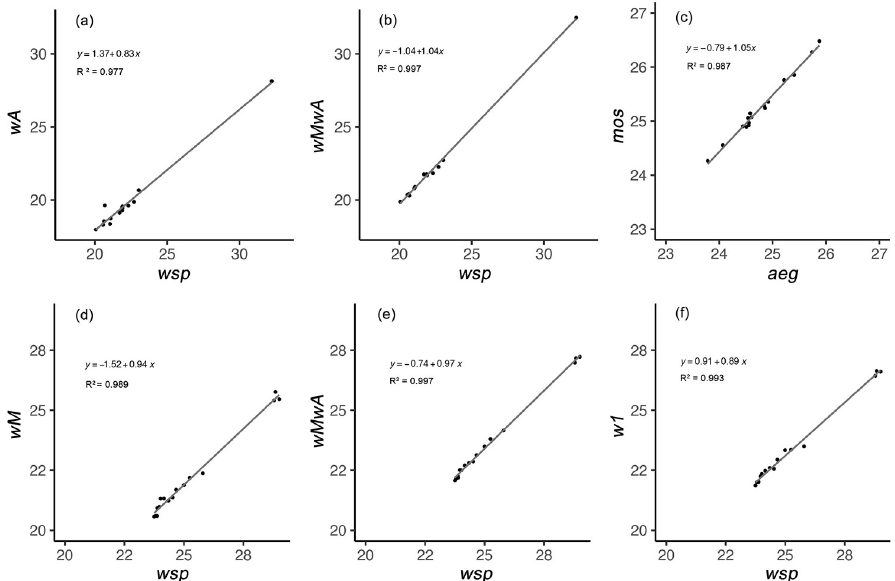
Fig 4. Variation in C q values when using different Wolbachia primers for the same samples. Correlation of C q values between (a) wA and wsp primers in Wolbachia w AlbBscreening; (b) wMwA and wsp primers in Wolbachia w AlbB screening; (c) mos and aeg primers in Aedes aegypti screening; (d) wM and wsp primers in Wolbachia w Melscreening; (e) wMwA and wsp primers in Wolbachia w Melscreening; (f) w1 and wsp primers in Wolbachia w